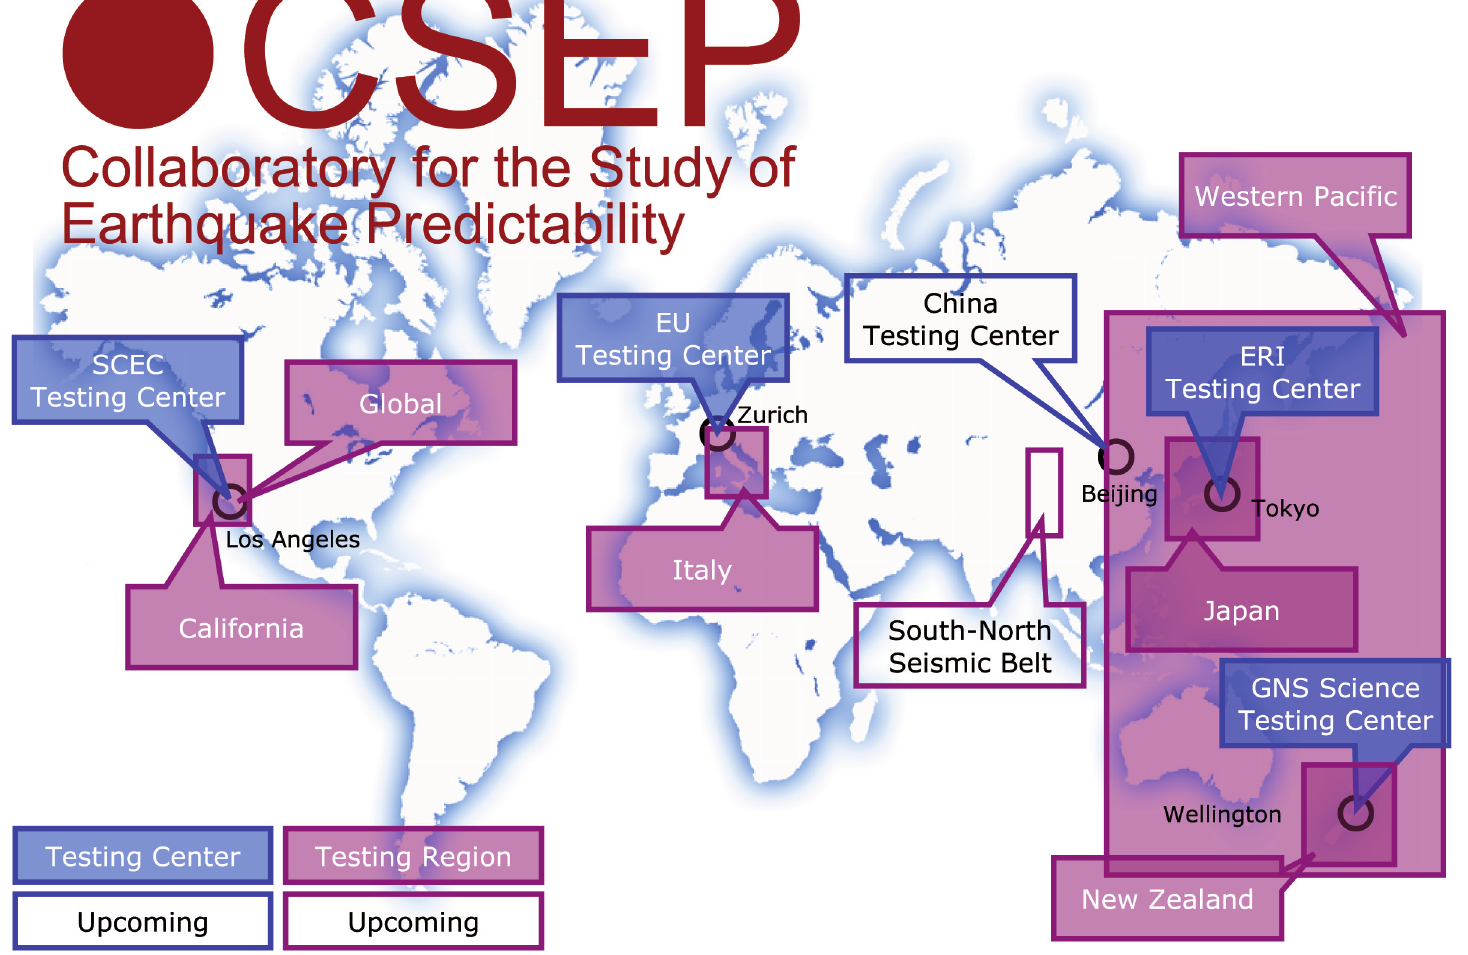
Figure 1 (top). Overview of the international CSEP testing centers and the test- ing